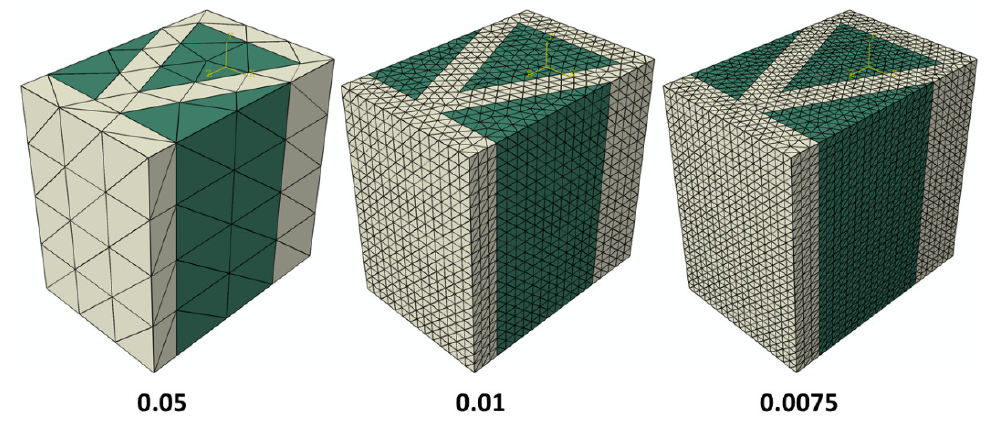
Figure 5. Three different mesh sizes of the triangular infill unit cell.